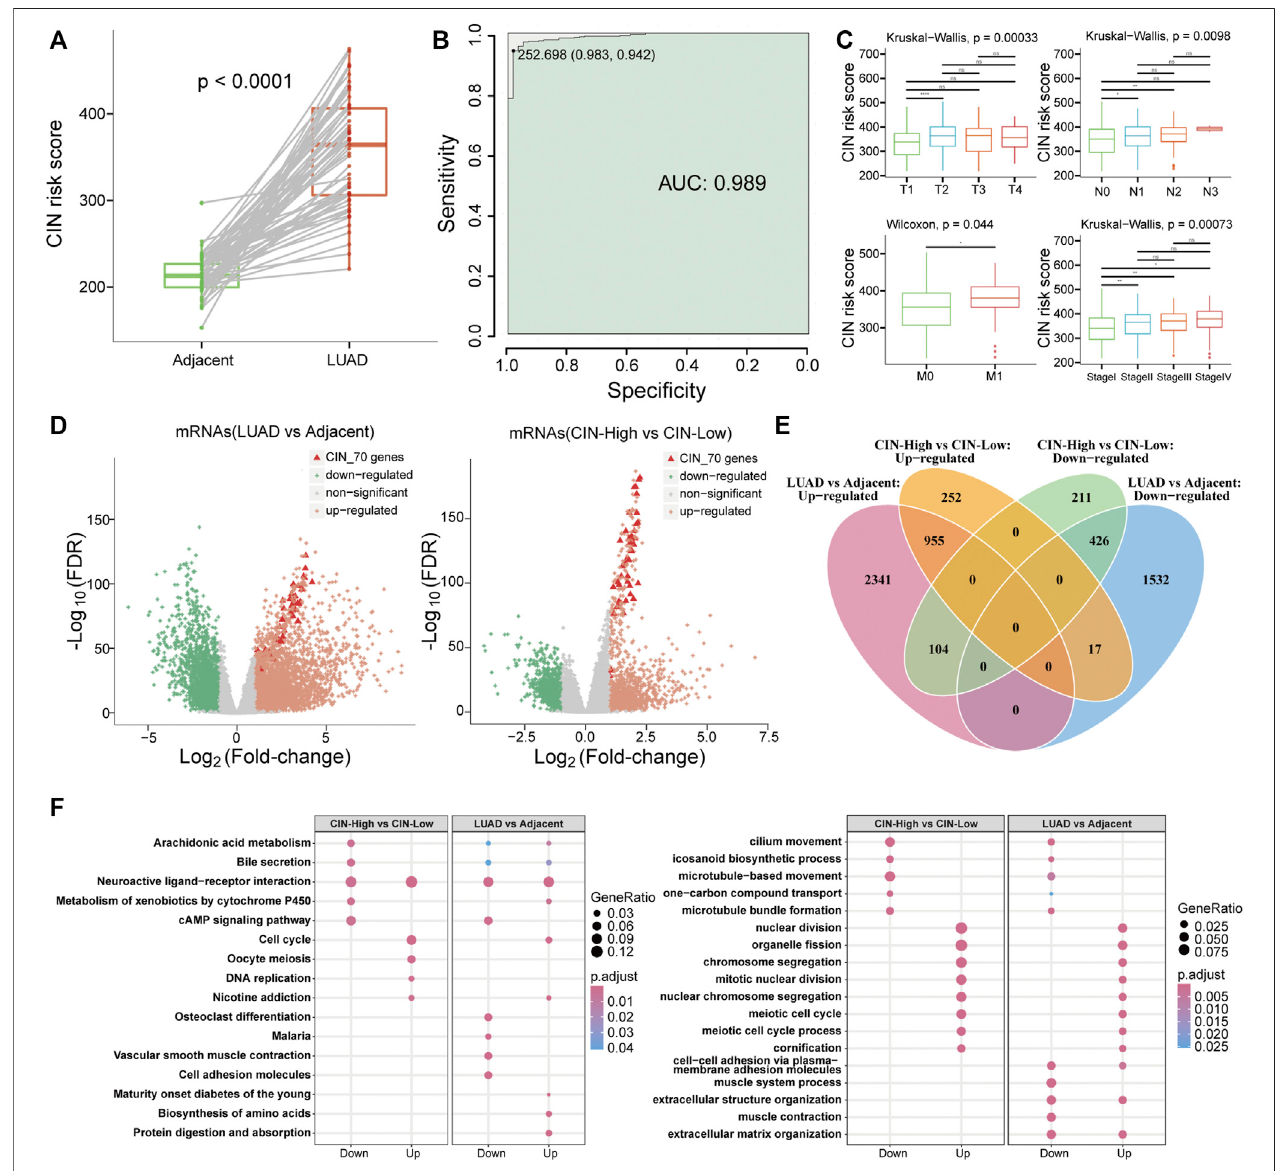
FIGURE 2 | Characteristics of chromosomal instability in lung adenocarcinoma. (A) Boxplot for CIN scores in LUAD and adjacent paired samples. The green column indicated adjacent normal samples, and the red column indicated LUAD tissues. (B) ROC curve of the CIN score in discriminating LUAD patients from adjacent normal samples. The green color indicated AUC. (C) Boxplots of patients ’ CIN scores in different TNM stages and clinical stages. (D) Volcano plots for identifying signi fi cantly differentially expressed genes in (left) lung adenocarcinoma samples versus adjacent samples and (right) CIN-High compared to CIN-Low group. (E) Venn diagram and (F) BP function and KEGG pathway enrichment results for differentially expressed genes in comparative groups of LUAD vs. Adjacent and CIN-High vs. CIN-Low.